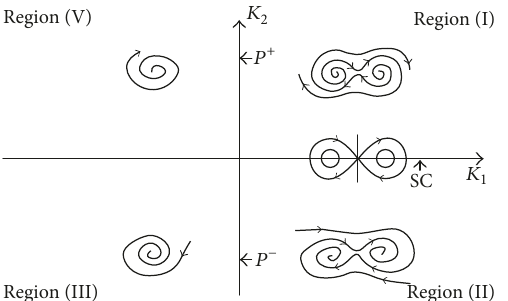
Figure 2: The bifurcation sets that are associated with typical phase portraits in each region, where 𝑃 + represents a subcritical pitchfork, 𝑃 − represents a supercritical pitchfork, and SC represents a homo- clinic bifurcation.